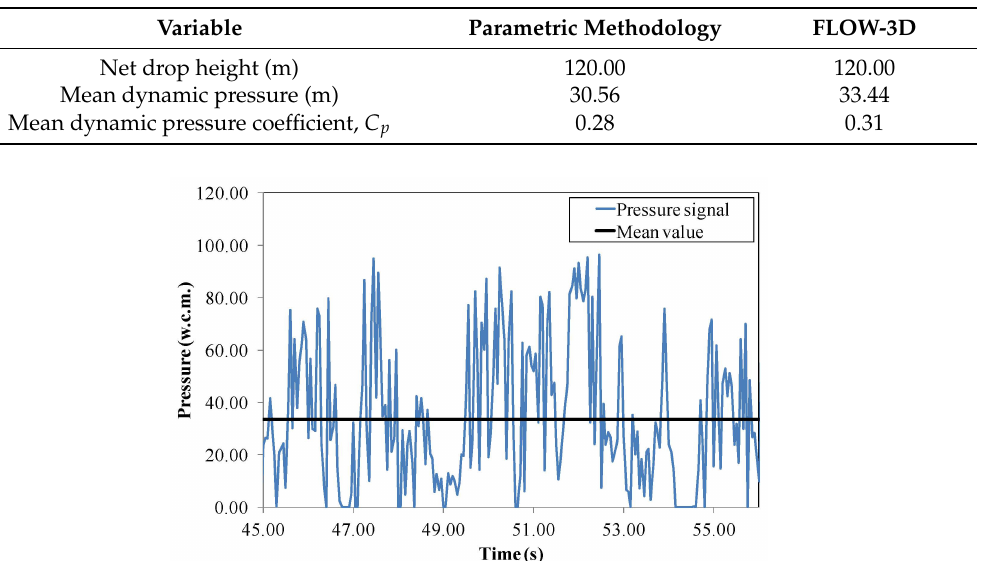
Table 7. Comparison of pressures and C p for the free surface weir, considering a water cushion Y 0 = 2 m (Castillo and Carrillo [25,26]).